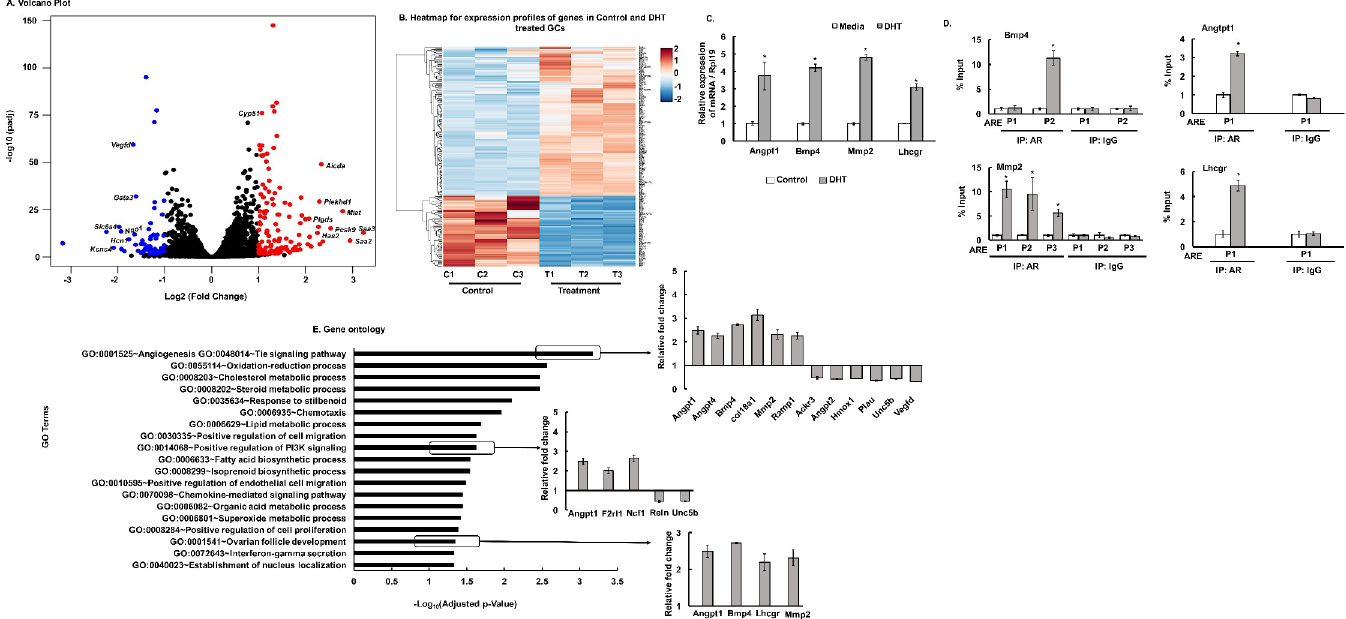
Fig 1. Androgen-induced transcriptome analysis in primary mouse granulosa cells (GC). A: Volcano plot: Representing the global transcriptional change across the groups compared. Each data point in the scatter plot represents a gene. Genes with an adjusted P � 0.05 and a log2 fold change � 1 are indicated by red dots and represent up-regulated genes. Genes with an adjusted P � 0.05 and a log2 fold change � -1 are indicated by blue dots and represent downregulated genes. B: Heatmap of differentially expressed genes sorted by adjusted p-value by plotting their log2 transformed expression values in samples. C: Relative expression of Bmp4 (Bone morphogenetic factor 4), Angpt1 (Angiopoietin 1), Mmp2 (Matrix Metallopeptidase 2) and Lhcgr (Luteinizing hormone/Choriogonadotropin receptor) mRNA levels by quantitative PCR in primary mouse GCs treated with media or DHT (25nM for 24h). Data are displayed as means ± SEM (n = 3 experiments, for each experiment GCs isolated from 5 mice were pooled together) and normalized to Rpl19 ( � P � 0.05, vs media). D: Anti-AR ChIP-assay in mouse primary GC cultures treated with media (control) or DHT (25nM for 24h) showing AR binding to different ARE sequences (P1/P2/P3) on Bmp4 (-693/-383Kb from TSS), Angpt1 (-1074Kb from TSS), Mmp2 (-937/-753/-332Kb from TSS) and Lhcgr (-47Kb from TSS) promoter region. IgG represents non-specific antibody. Values represent percentage input. Data are displayed as mean ± SEM (n = 3 experiments, for each experiment GCs isolated from 10 mice were pooled together) and � P � 0.05, vs media. E: Gene ontology analysis: Gene ontology terms of significantly enriched pathways with an adjusted P-value � 0.05 in the differentially expressed gene sets.